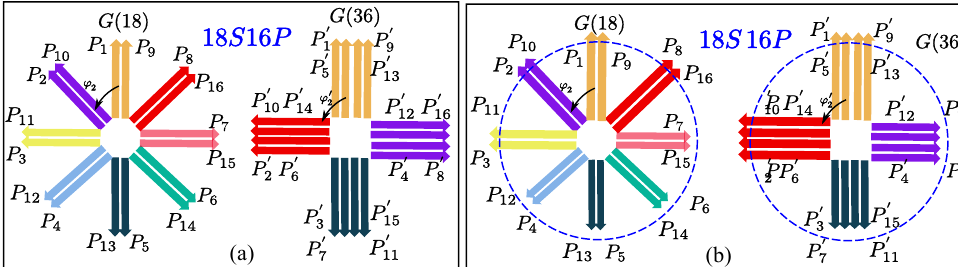
Figure 3. The vector diagram for 18S16P configuration, ( a ) the ideal-case, ( b ) the worst-case un- certainties combinations of PM that would cause the maximum 18th and 36th additional cogging torque harmonics.